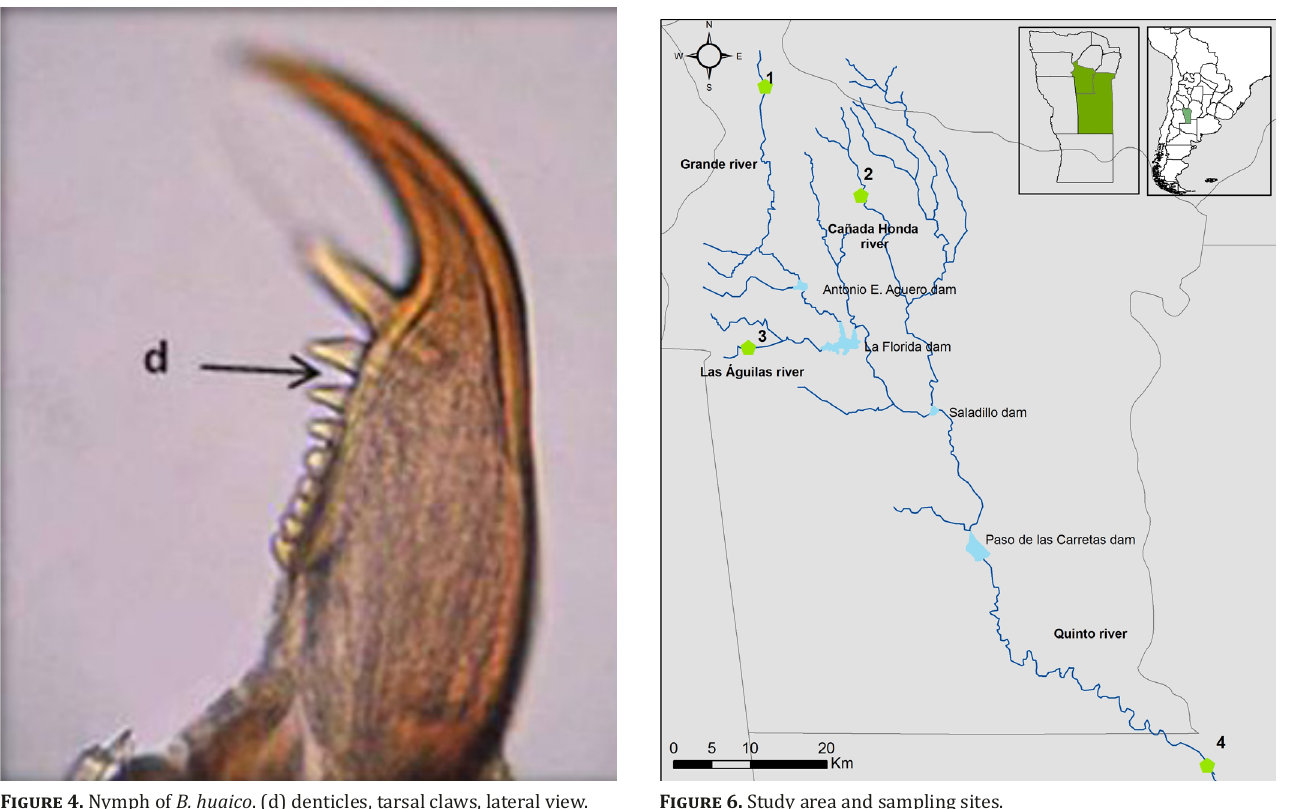
Figure 6. Study area and sampling sites.